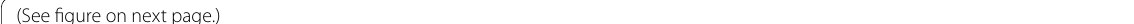
Fig. 1 A10-FMT decreased blood glucose, and improved semen quality in type 1 diabetes. a Blood glucose levels. The y-axis represents the concentration. The x-axis represents the treatment (n 30/group). * p < 0.05. b Blood glycogen levels. The y-axis represents the relative amount. = The x-axis represents the treatment (n 30/group). * p < 0.05. c Sperm concentration. The y-axis represents the concentration. The x-axis represents = the treatment (n 30/group). * p < 0.05. d Sperm motility. The y-axis represents the percentage of cells. The x-axis represents the treatment (n = group). * p